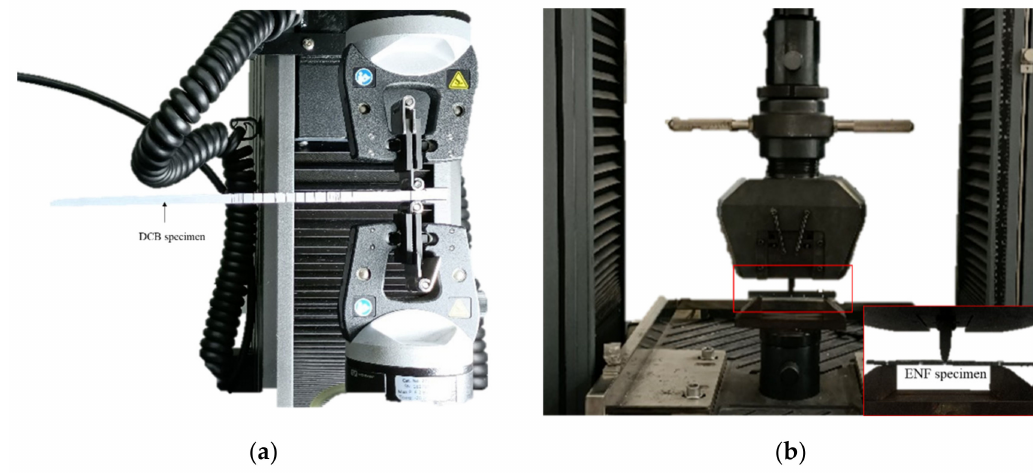
Figure 5. Fracture toughness tests: ( a ) DCB test and ( b ) ENF